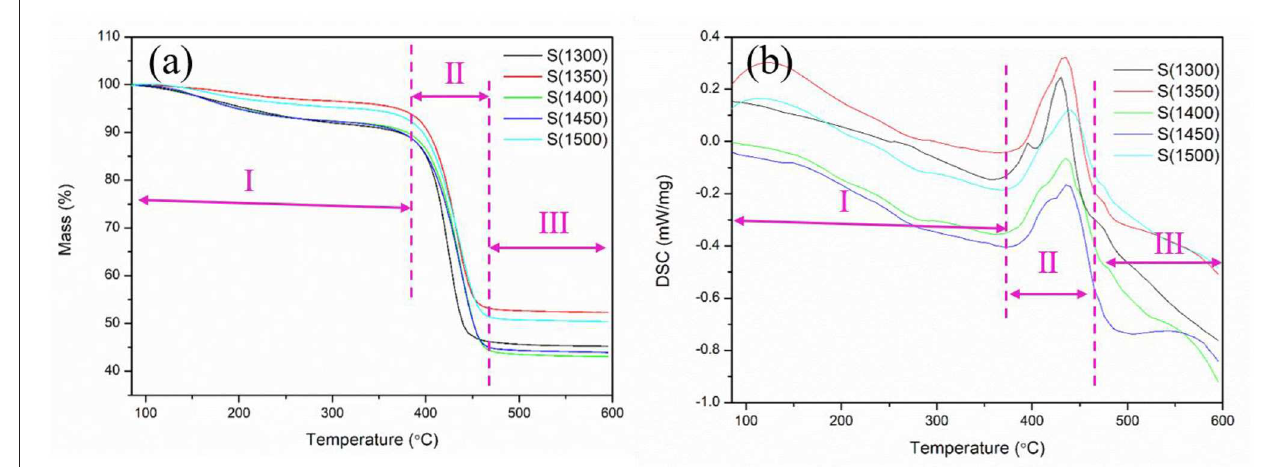
FIGURE 3 | TG-DSC curves of the green bodies: (a) TG curve; (b) DSC